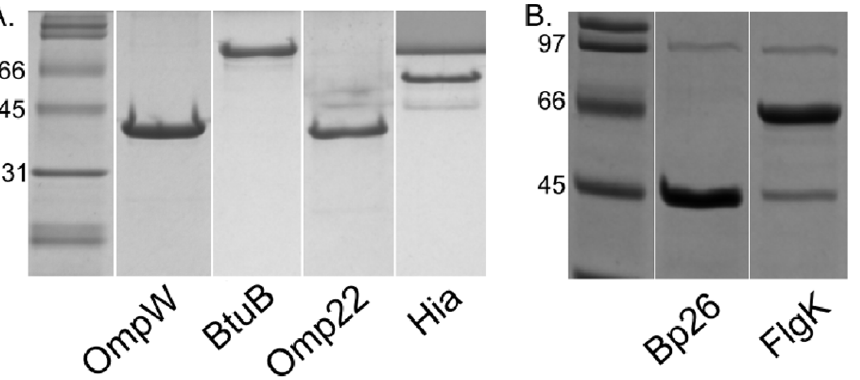
Figure 2. Purified Brucellamelitensis 16M outer membrane proteins expressed as SUMO-fusion proteins in BL-21 E.coli cells. OmpW, BtuB, Omp22, and cell surface protein expressed in inclusion bodies were purified by centrifugation, solubilized with guanidine HCl, and separated in gel filtration column. Bacterial lysates containing BP26 and FlgK in the soluble fraction were directly purified in an S-300 gel filtration column. Purified protein fractions were diluted with SDS loading buffer, incubated at 95 u C for 5 minutes and electrophoresed in a 12.5% SDS-PAGE gel.